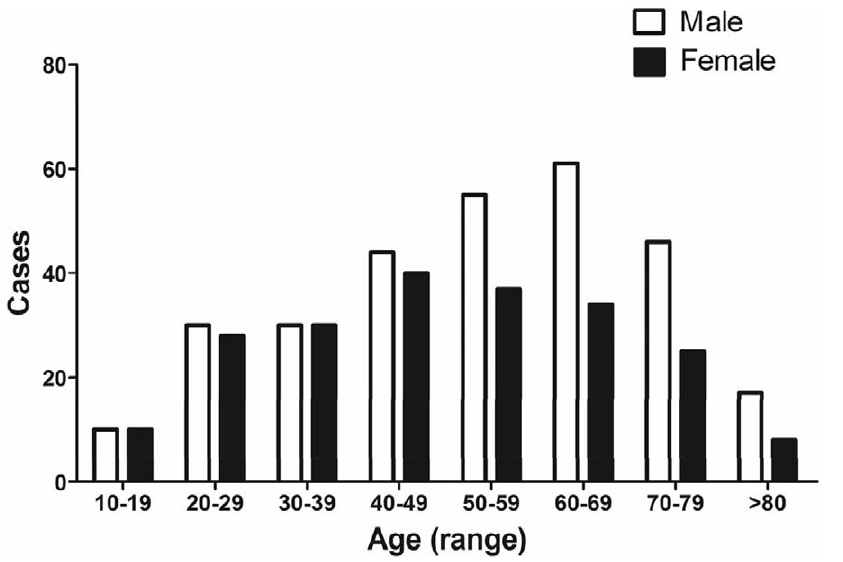
Figure 1. Distribution of age and gender in MDS patients. Male-to-female ratio in MDS patients gradually increases from the young to the old. Similar incidence of MDS could be observed in the younger male and female patients before age 60. However, the older male patients have higher incidence of MDS compared with the older female patients.